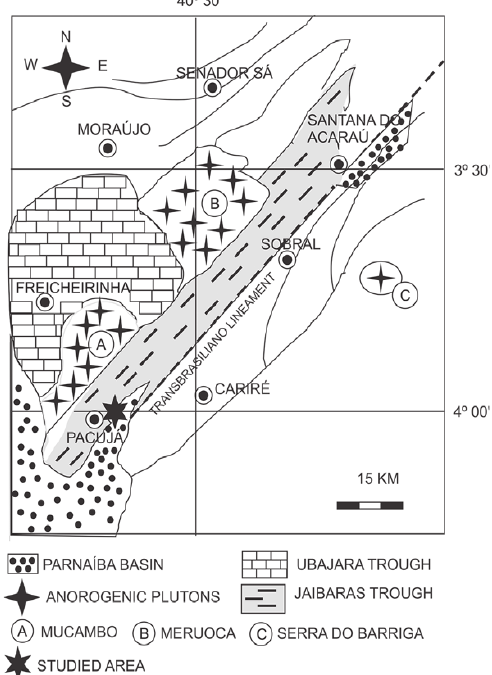
Figure 2 - Regional geology of northeastern Ceará (Modifi ed from Oliveira and Mohriak